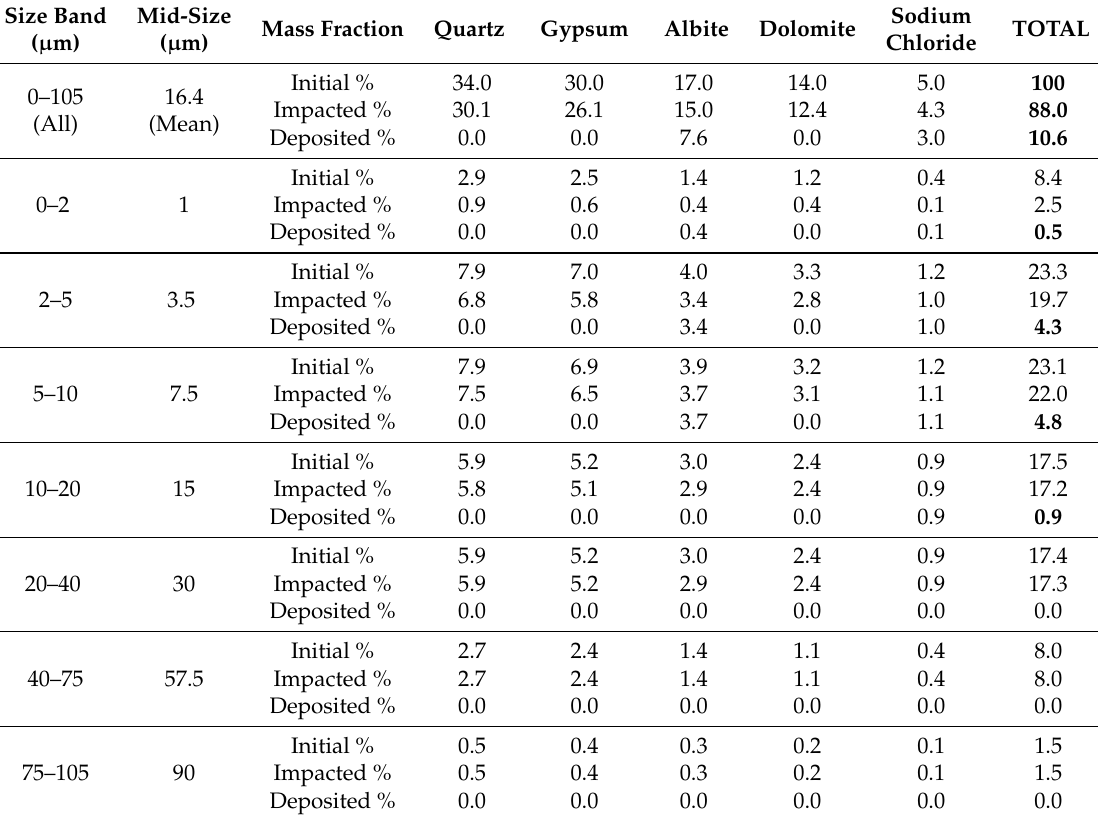
Table 3. Table of proportions by mass in each size band and mineral, of initial test dust, of impacted dust and of deposited dust. All percentages are relative to the initial mass. The numbers in bold emphasise the overall values: they are a summation of the proportions of each mineral and each size